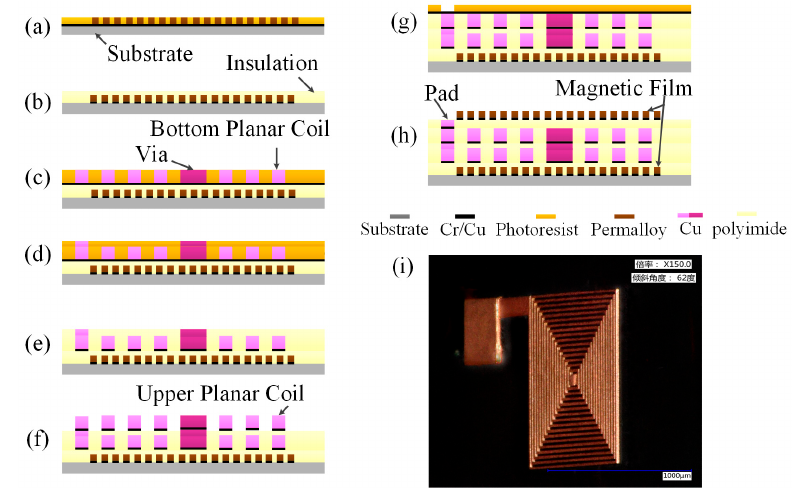
Figure 7. Main fabrication processes of the micro-inductor ( a )–( h ) and optical photograph of the single coil ( i ).